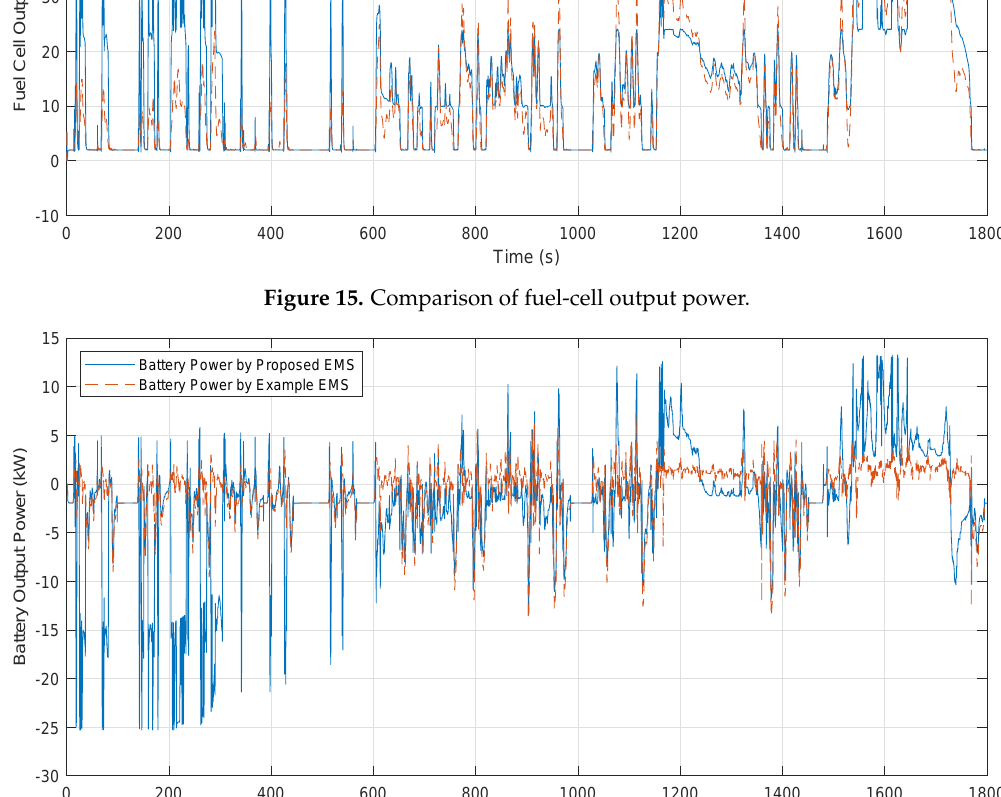
Figure 16. Comparison of battery-output